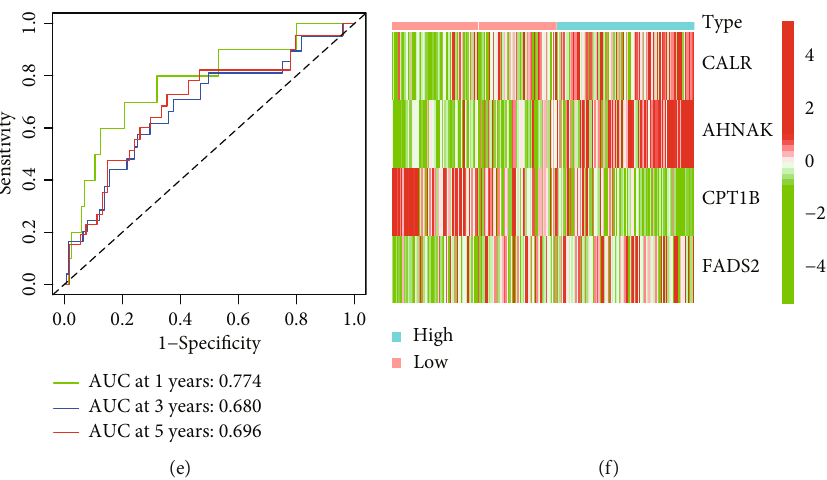
Figure 5: Validation of the PPAR signature in the GEO dataset. (a – e) Kaplan-Meier curve showed that low-risk patients had better survival compared with the high-risk patients. The distribution of overall survival between the high-risk group and the low-risk group. The distribution of PPARscore between the high-risk group and the low-risk group ((a) GSE13507; (e) GSE32894); (b – f) time-independent receiver operating characteristic (ROC) analysis for evaluating the predictive performance of PPARscore ((b) GSE13507; (f) GSE32894); (c – g) heatmap showed the expression patterns of 4 genes between the high- and low-risk groups ((c) GSE13507; (g) GSE32894). The blue box represented the GSE13507 dataset; the red box represented the GSE32894